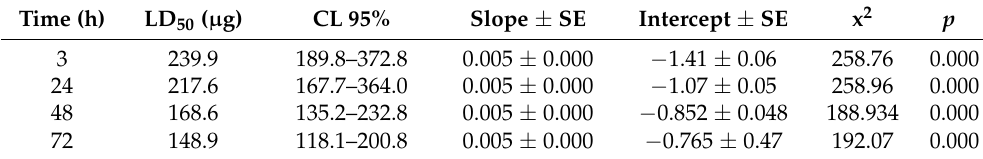
Table 4. Larvicidal activity of PLF He recorded at 3, 24, 48, and 72 h after topical application bioassay. LD 50 values are considered significantly different when 95% CL fail to overlap. Since goodness-of-fit test is significant ( p < 0.05), a heterogeneity factor is used in the calculation of confidence limits (CL). Time